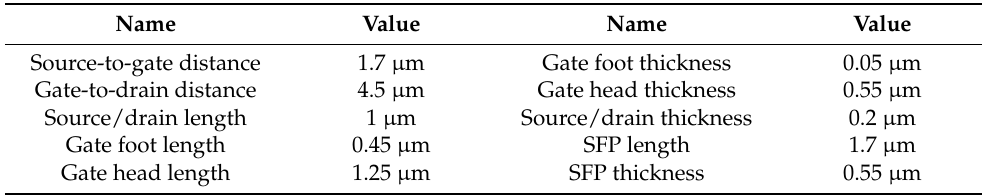
Table 1. Dimension parameters for